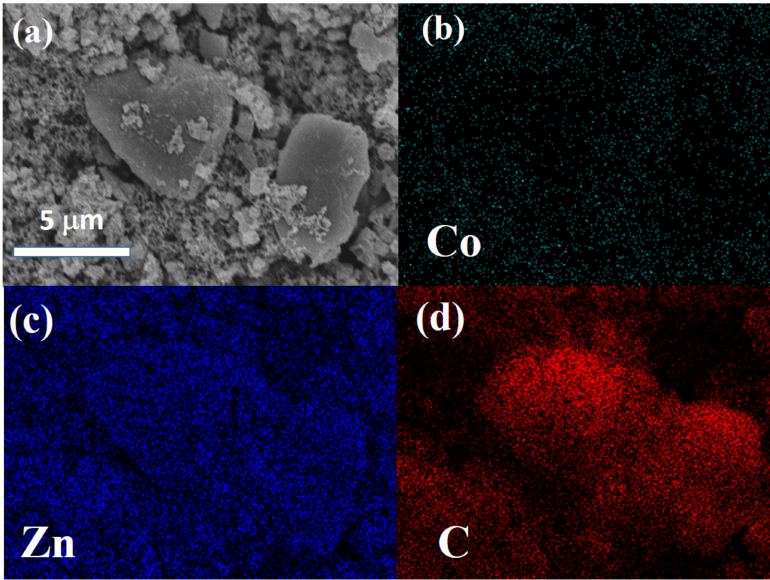
Figure 3. ( a ) SEM and EDS mapping of ( b ) Co, ( c ) Zn, and ( d ) C of Co/ZnO-NC.